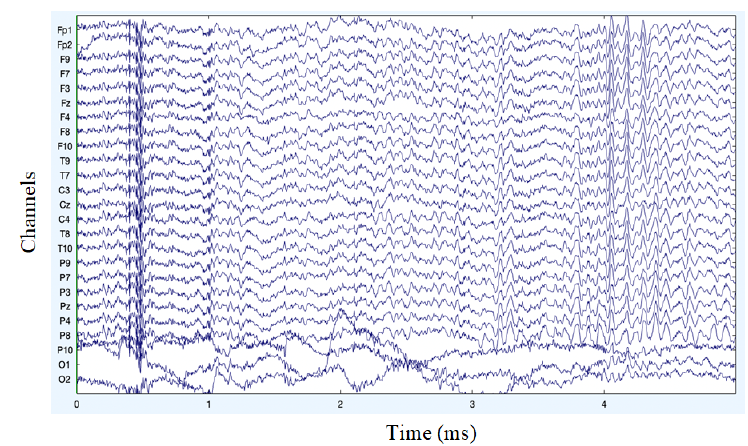
Figure 3. Original channel data of MI signals.